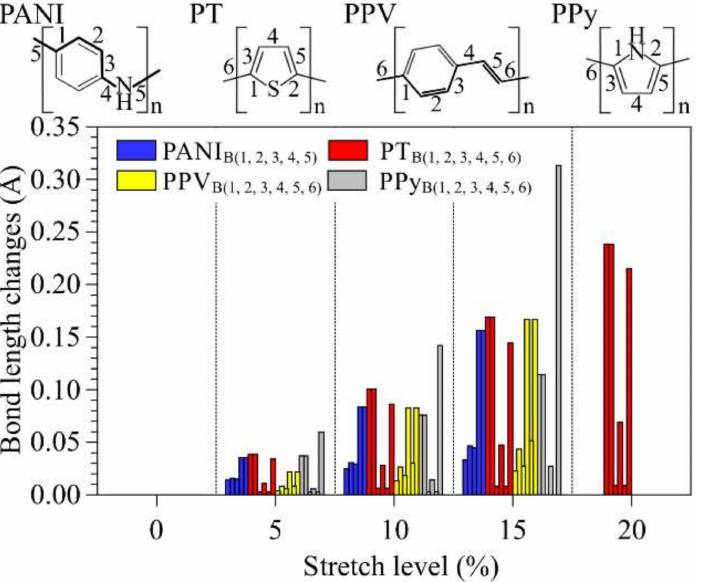
Figure 4. Summary of the changes in polymer bond lengths at distinct stretch